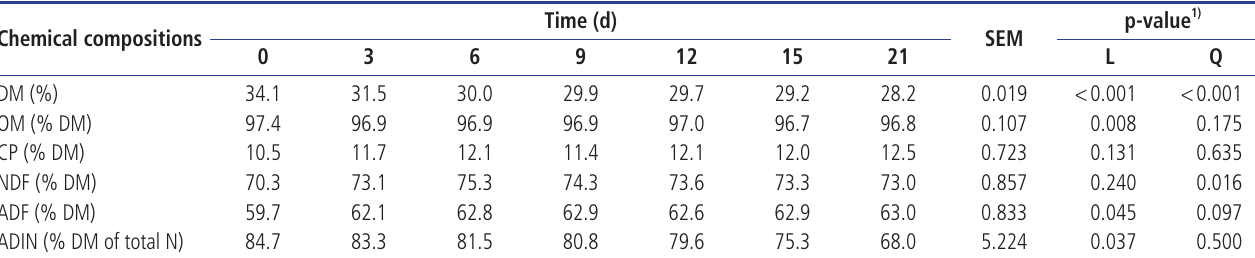
Table 4. Changes of chemical composition in spent instant coffee grounds according to fermentation time Chemical compositions